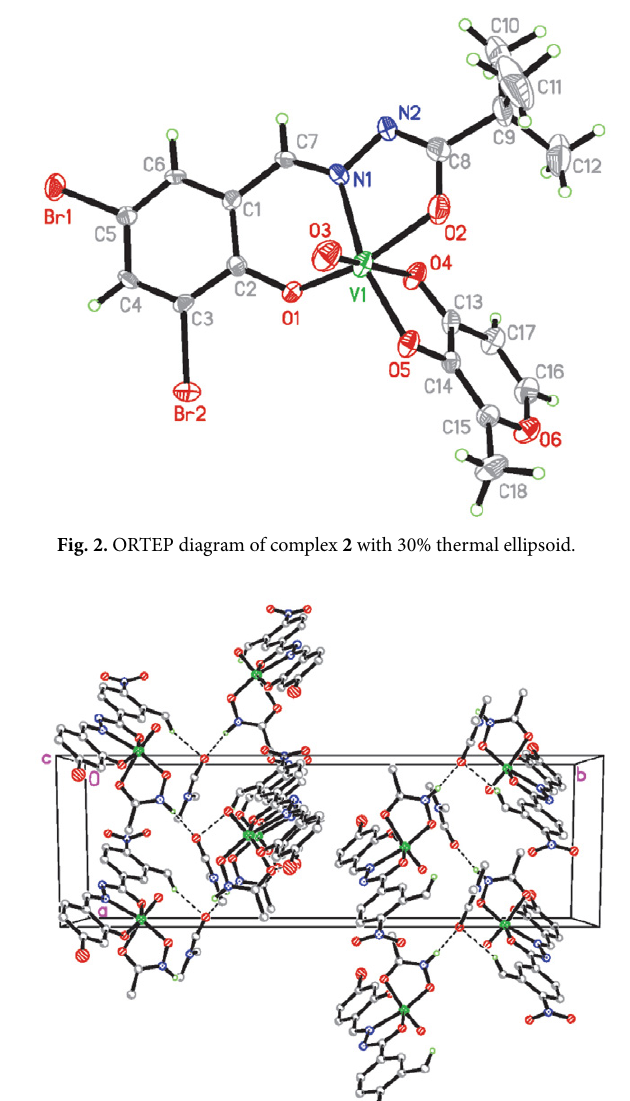
Table 2. Selected bond distances (Å) and bond angles (°) for the complexes